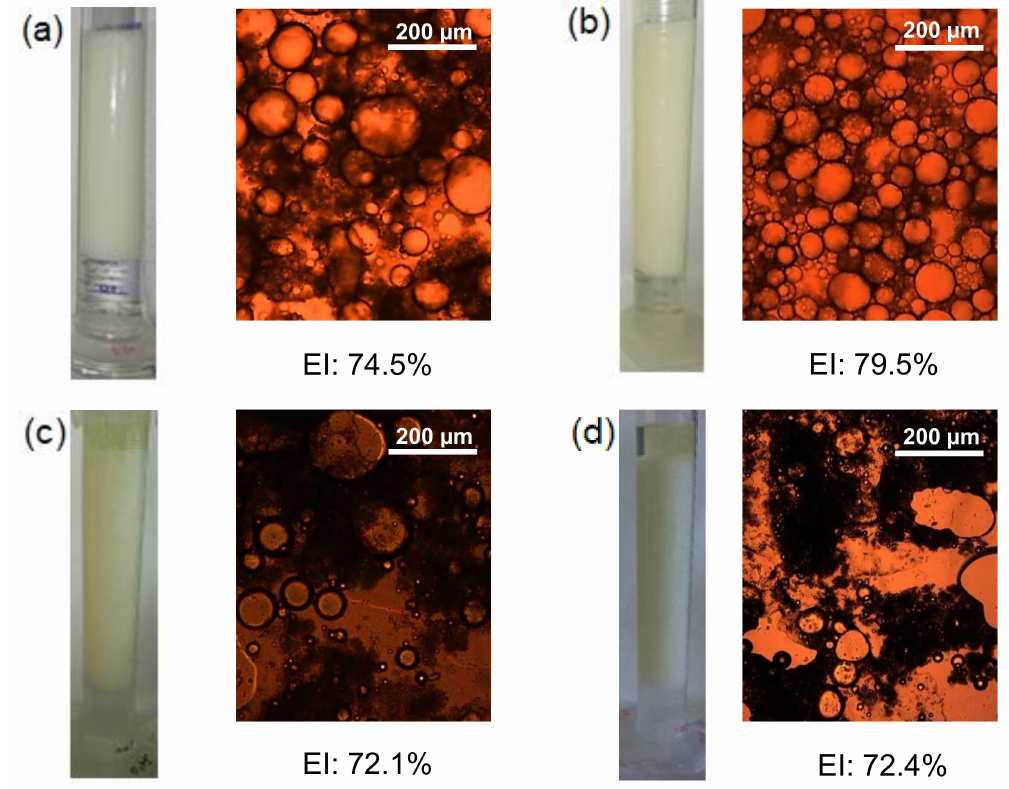
Figure 5. Microscope images of emulsion phases and photographs of the graduated cylinder after 48 h with 0.75 wt% CMF using different O/W ratios: ( a ) 40/60, ( b ) 50/50, ( c ) 60/40, ( d )